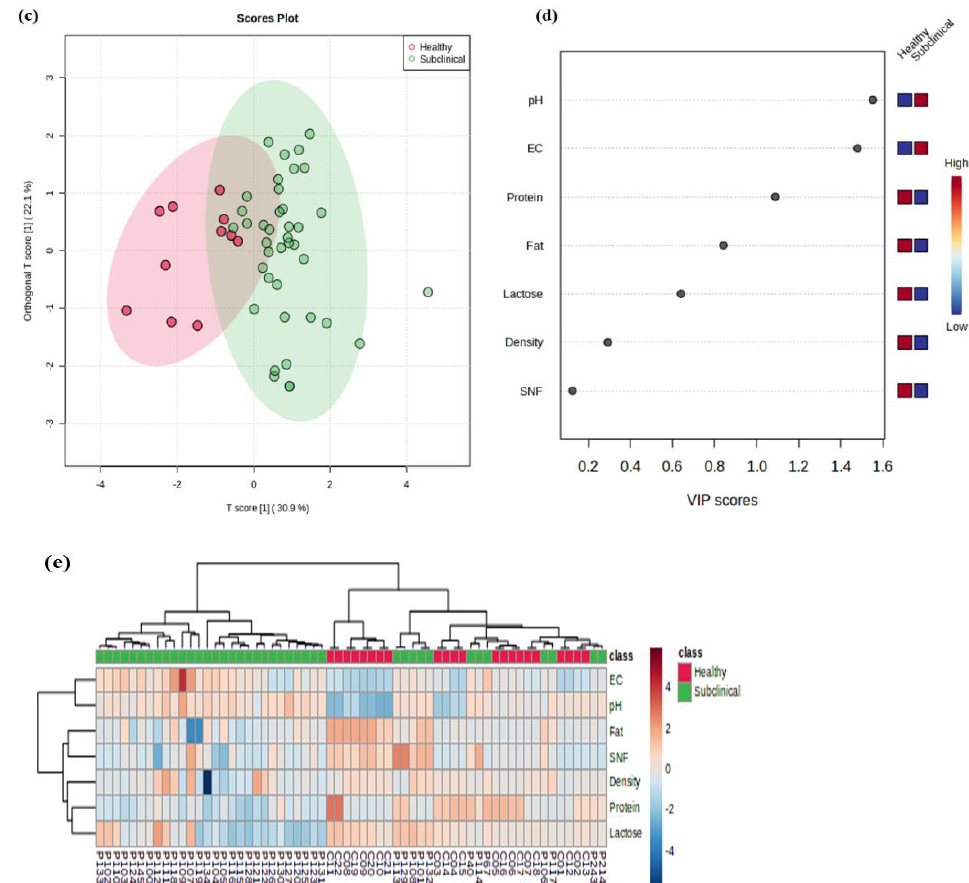
Figure 3. ( a ) PCA score plots of milk metabolites; ( b ) sparse partial least squares discriminant analysis (sPLS-DA) of the metabolites detected in the milk samples of healthy and subclinical mastitis animals. The data have been normalized and represent the mean values of overall samples (0 = Healthy and 1 = Subclinical); ( c ) Orthogonal partial least-squares discriminant analysis (oPLS-DA) score plot of a comparison between healthy and subclinical mastitis groups; ( d ) VIP plot of milk metabolites; ( e ) Hierarchical clustering heat map analysis of milk chemistry metabolite variations between control and subclinical mastitis dairy animals. Data have been normalized with unit variance scaling and the average values of the samples are shown. Comparisons were generated via an average linkage method based on Euclidean distance. Shades from blue to red represent increasing metabolite levels.